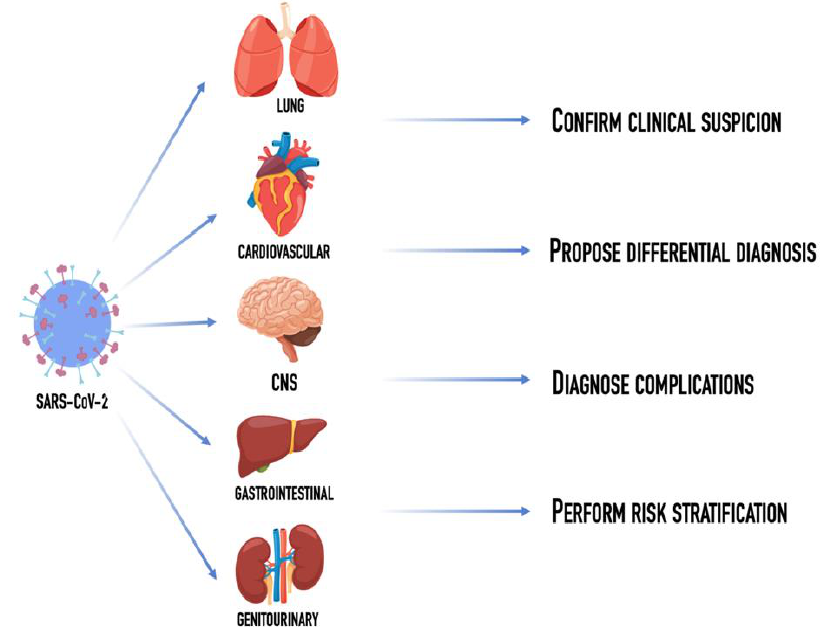
Figure 1. Schematic representation of the role of diagnostic radiology: confirm clinical suspicion in case of non-diagnostic polymerase chain reaction test, help solving the differential diagnosis, identify and follow the progression of possible complications and, finally, perform a risk stratification of patients affected with SARS-CoV-2.